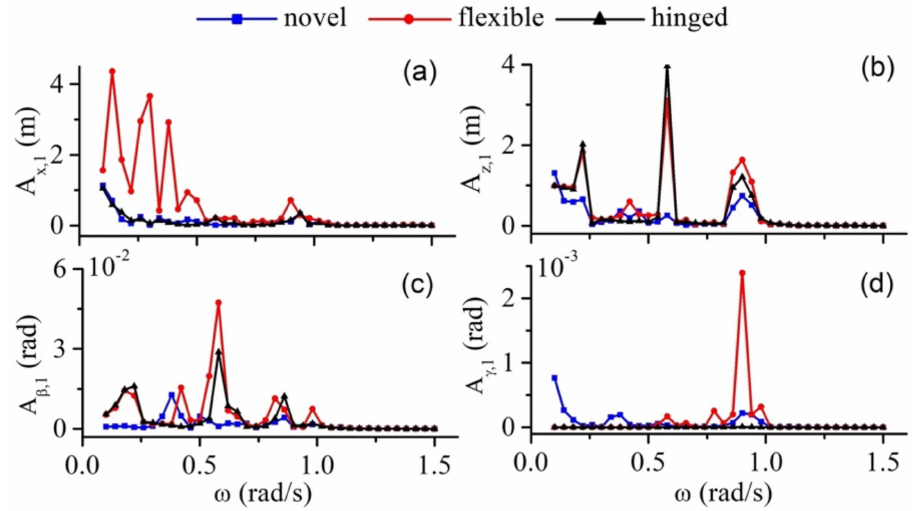
Figure 7. The response amplitudes of the first module in the ( a ) surge, ( b ) heave, ( c ) pitch, and ( d ) yaw motions versus the wave frequency at the wave incident angle of 0 ◦